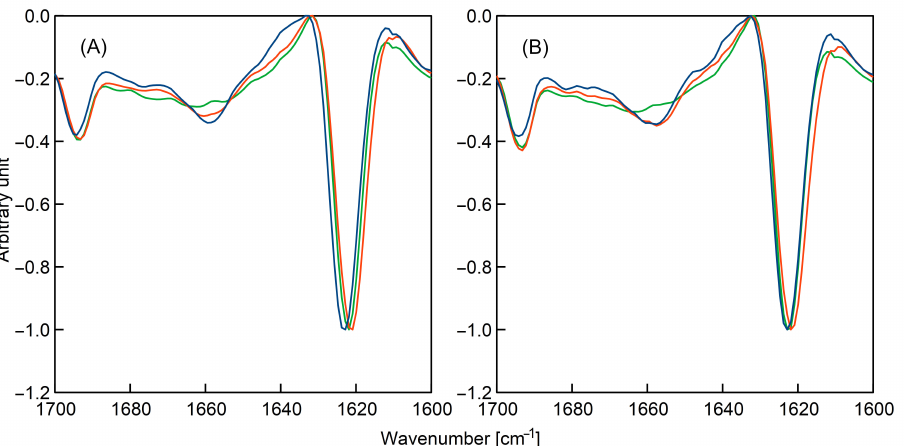
Figure 5. Infrared spectra—expressed as second derivatives of absorbance—recorded for: ( A ) samples of non-incubated freshly prepared solutions of the K-peptide and ( B ) samples of the K-peptide incubated at 37 ◦ C for 14 days. The peptide was dissolved in: water (blue line); acetate buffer, pH = 4, without additives (red line) and acetate buffer with dimethyl sulfoxide (green